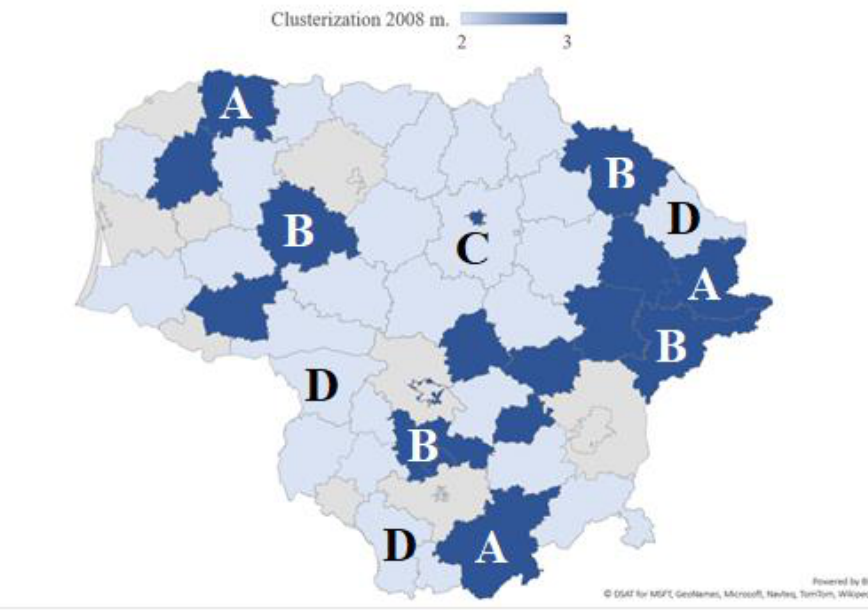
Figure 1. The results of clustering applying clusters analysis of 2008.